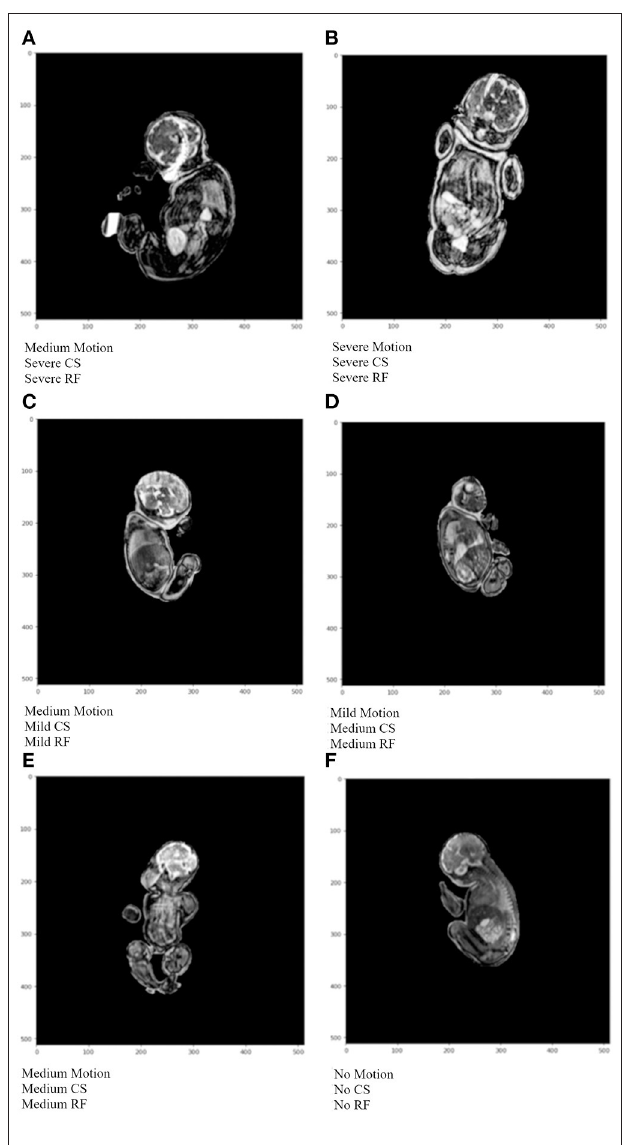
FIGURE 8 | Example algorithm outputs of overall artifact severity for test images where CS represents chemical shift artifacts, and RF represents radio-frequency artifacts. In (A) medium motion, and severe CS and RF were detected. (B) shows severe artifacts for all 3 artifact types. (C) depicts medium motion, and mild CS and RF artifacts. In (D) mild motion, and medium CS and RF artifacts were detected. In (E) medium severity was detected for all artifact types. In (F) no artifacts were